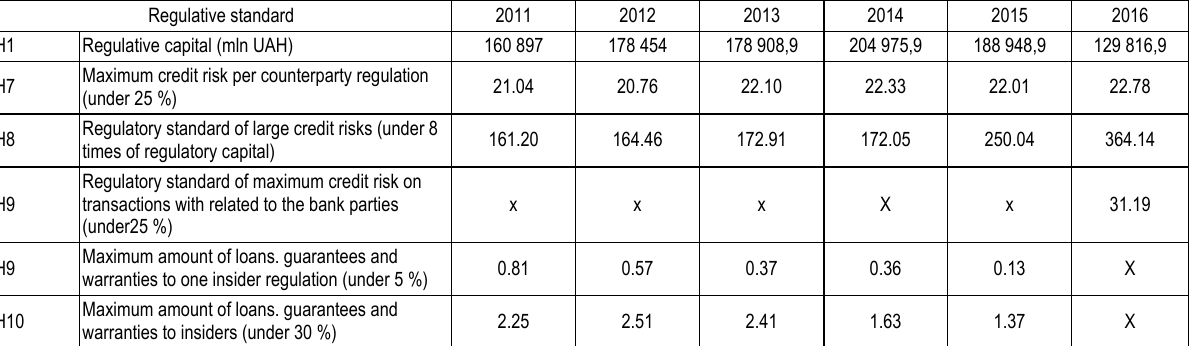
Table 2. Credit risk regulative standards of the National Bank of Ukraine in the period of 2011-2016* Regulative